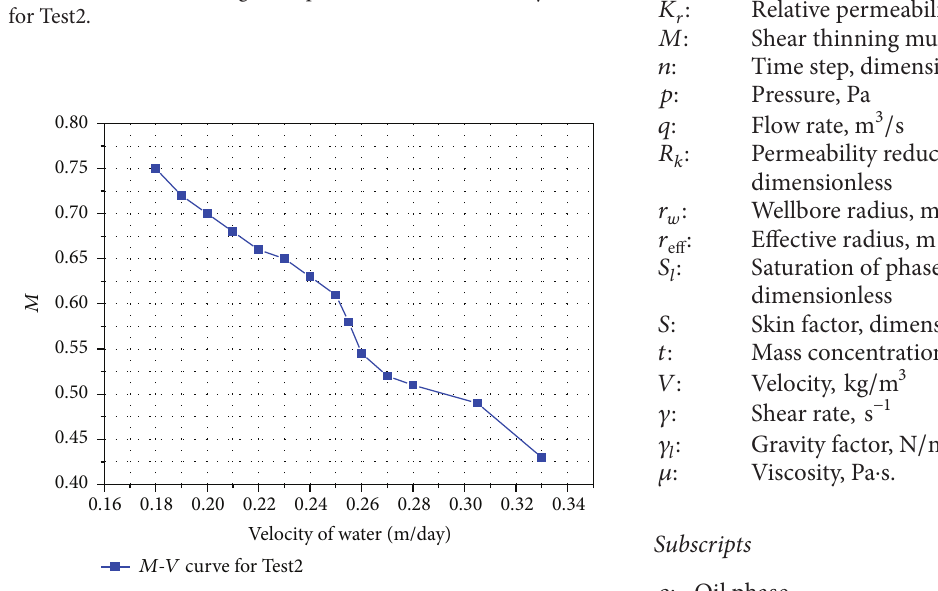
Figure 15: Interpreted 𝑀 - 𝑉 shear thinning curve.